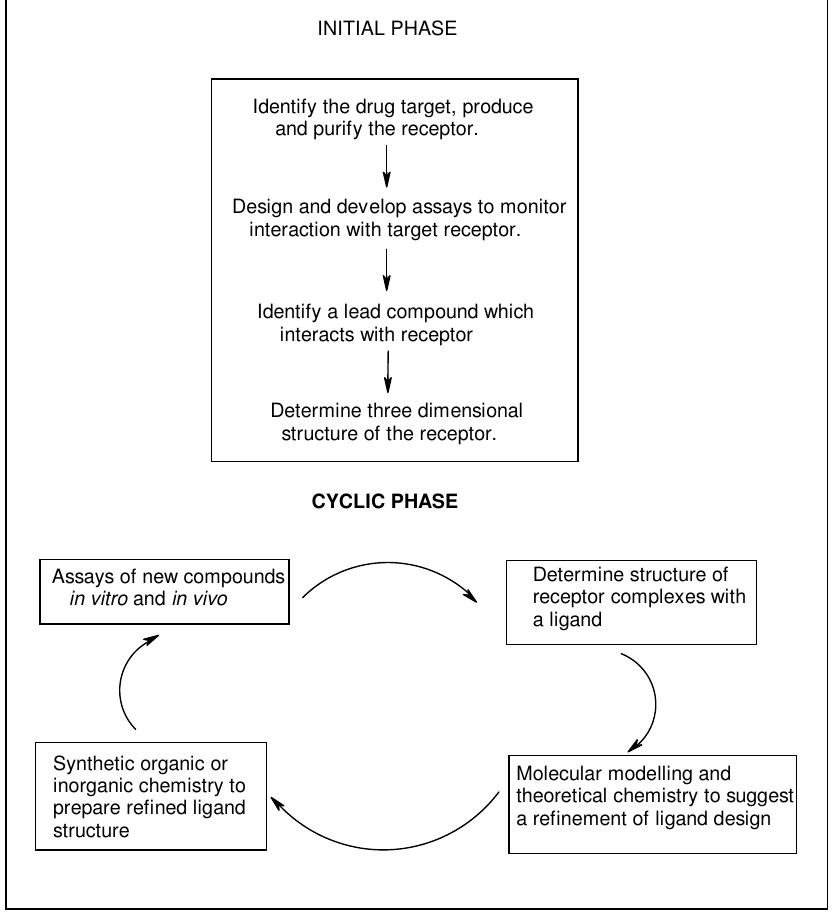
Figure 2. A representation of structure based drug design. An initial exploratory phase is followed by cycles of structure determination by X-ray crystallography, NMR or other methods, molecular modeling, synthetic chemistry, and biological